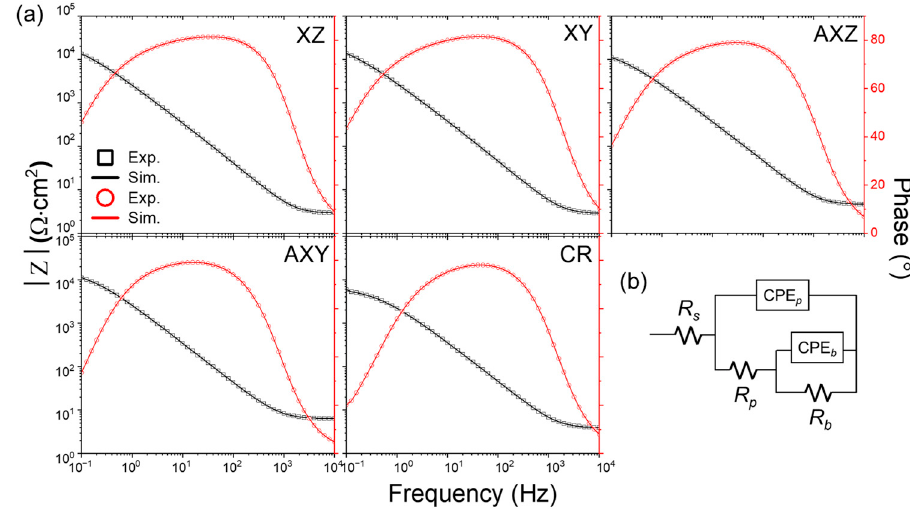
Figure 4. ( a ) Bode spectra for each specimen in 3.5 wt.% NaCl solution. ( b ) Equivalent circuit for data fitting. Table 3. Fitted data for parameter of equivalent circuit.